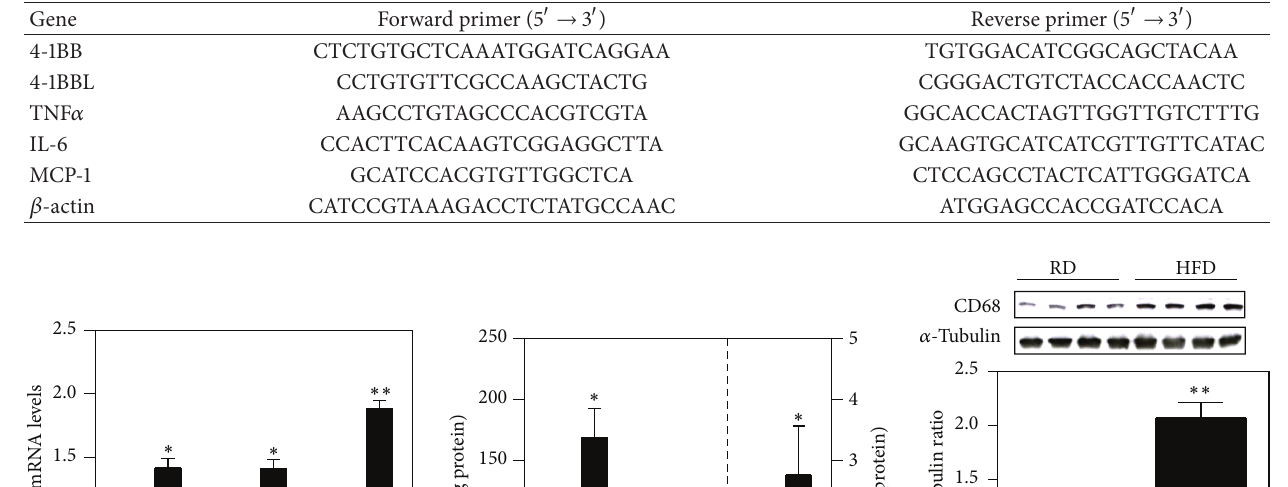
Table 1: Mouse primers used for qRT-PCR analysis.